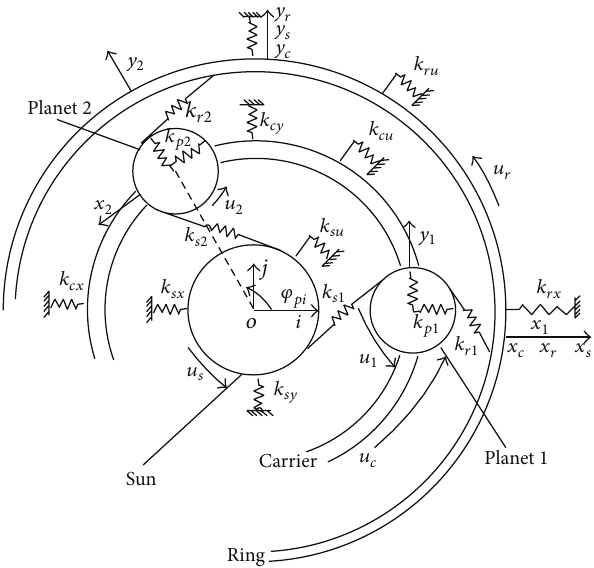
Figure 1: The dynamic model for a planetary gear system.